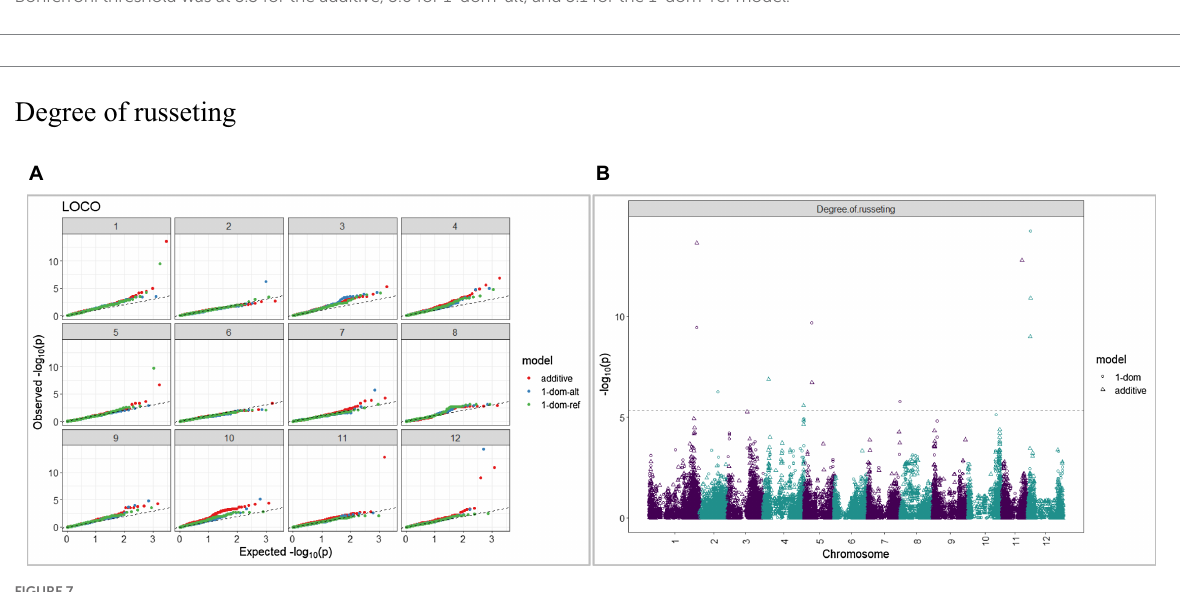
FIGURE 7 Q–Q plots of observed vs. expected -log10 ( p values) ( A ) and corresponding Manhattan plot (B) for a degree of russeting using the additive and dominant model for tuber traits of 214 potato clones evaluated in three environments in Texas: Dalhart 2019, 2020 and Springlake 2020. The Bonferroni threshold was at 5.3 for the additive, 5.0 for 1-dom-alt, and 5.1 for the 1-dom-ref